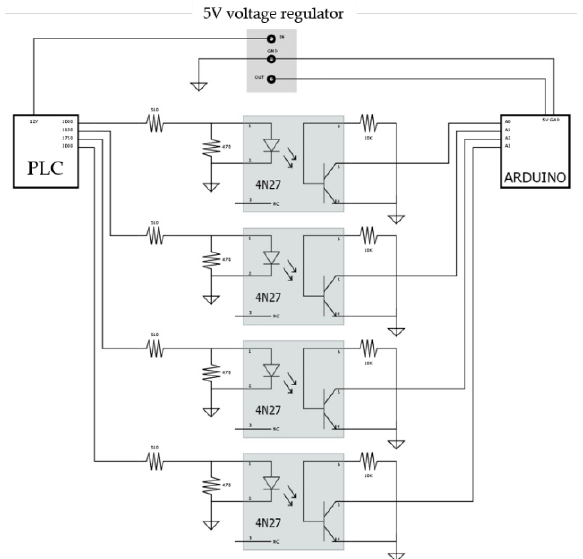
Figure 2. The interface module (IM) positioned between the Arduino and programmable logic controller (PLC) blocks.